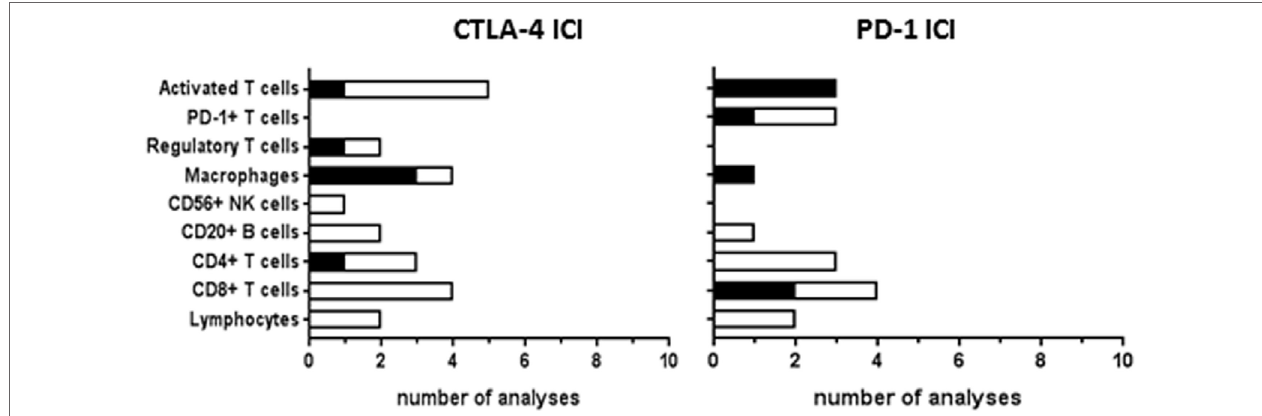
FiGURe 6 | Tumor-infiltrating cells analyzed as immune checkpoint inhibitor (ICI) response biomarker. Graphs show the number of analyses per biomarker type for correlations with clinical response to CTLA-4 or PD-1 ICI therapy. Black bars, significant correlation; white bars, non-significant correlation. Progression-free survival and overall survival were not analyzed in most of the